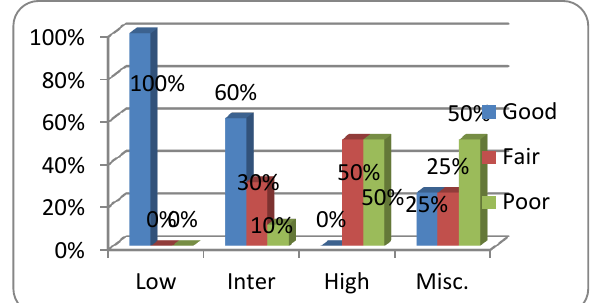
Figure 6: Development state of EAS in ARM patients of various